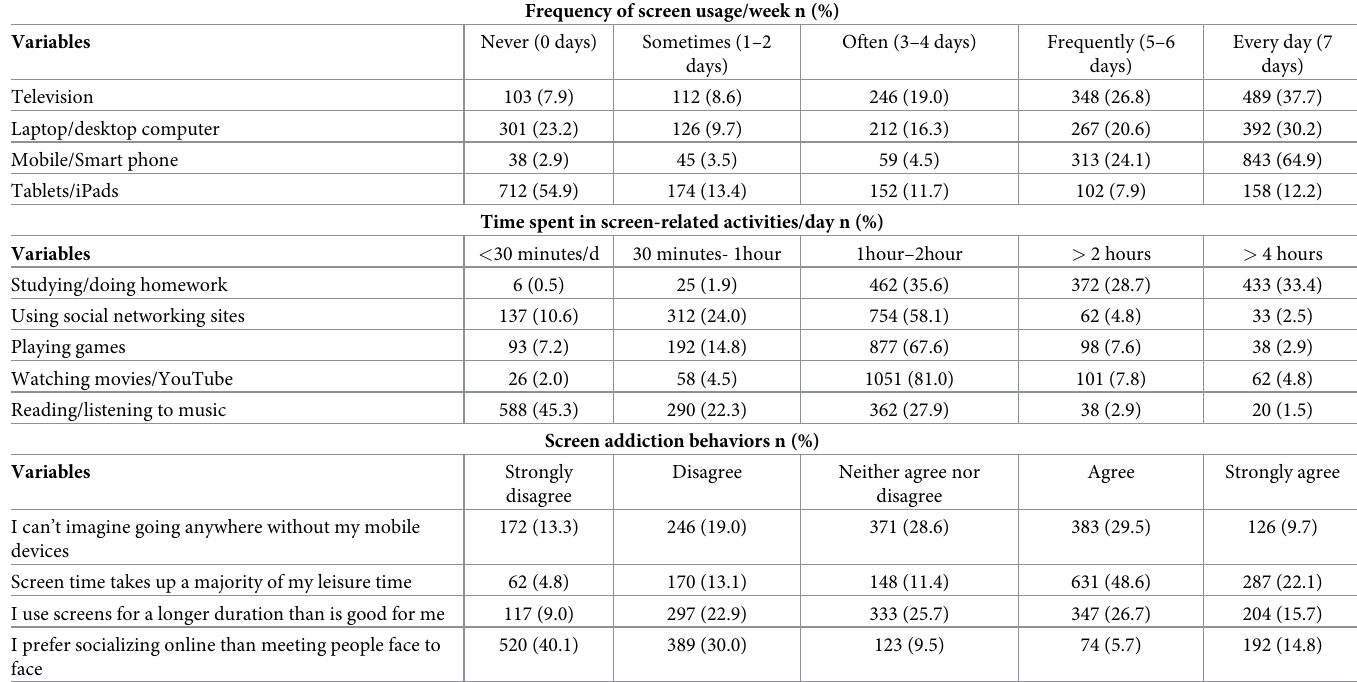
Table 2. Screen related behaviors of 10–15 years old adolescents (n = 1298) in the study. Frequency of screen usage/week n